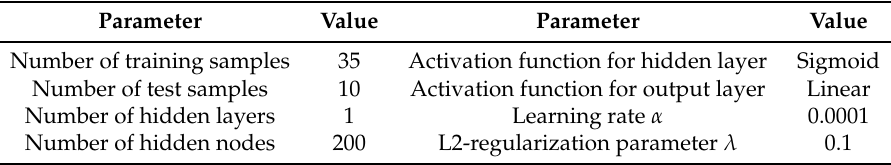
Figure 5. Schematic of a general neural network (NN) having 2 input nodes and 4 output nodes, with multiple hidden layers with each hidden layer having multiple hidden nodes. NN used in this study was comprised of a single hidden layer. Table 2. Back Propagation Neural Network (BP-NN)